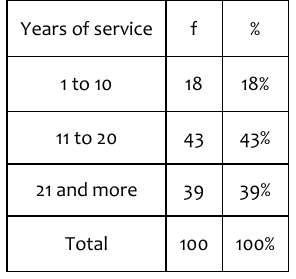
Table 1: The sample of teachers by variable: Years of